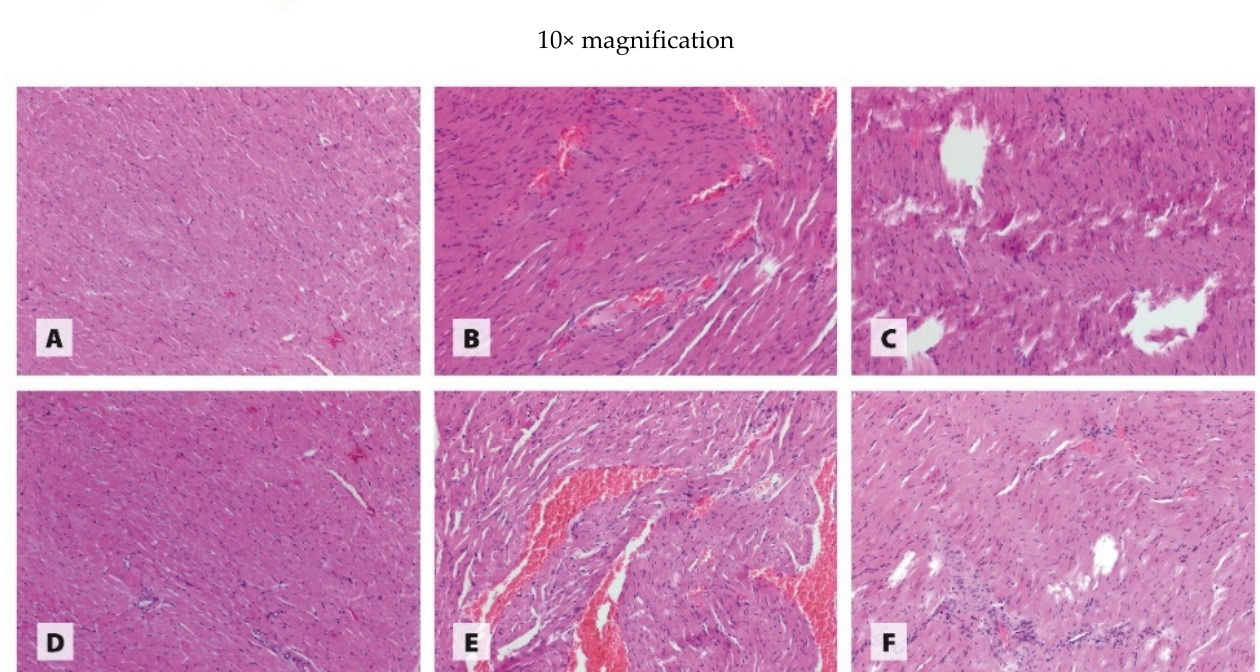
Figure 1. Morphological effects of different blood pressure and Cu sources on the heart muscle of rats. Treatments: ( A ) WKY CuCO 3 6.5 , ( B ) WKY CuCO 3 3.25 + CuNP 3.25 , ( C ) WKY CuNP 6.5 , ( D ) SHR CuCO 3 6.5 , ( E ) SHR CuCO 3 3.25 + CuNP 3.25 , and ( F ) SHR CuNP 6.5 .